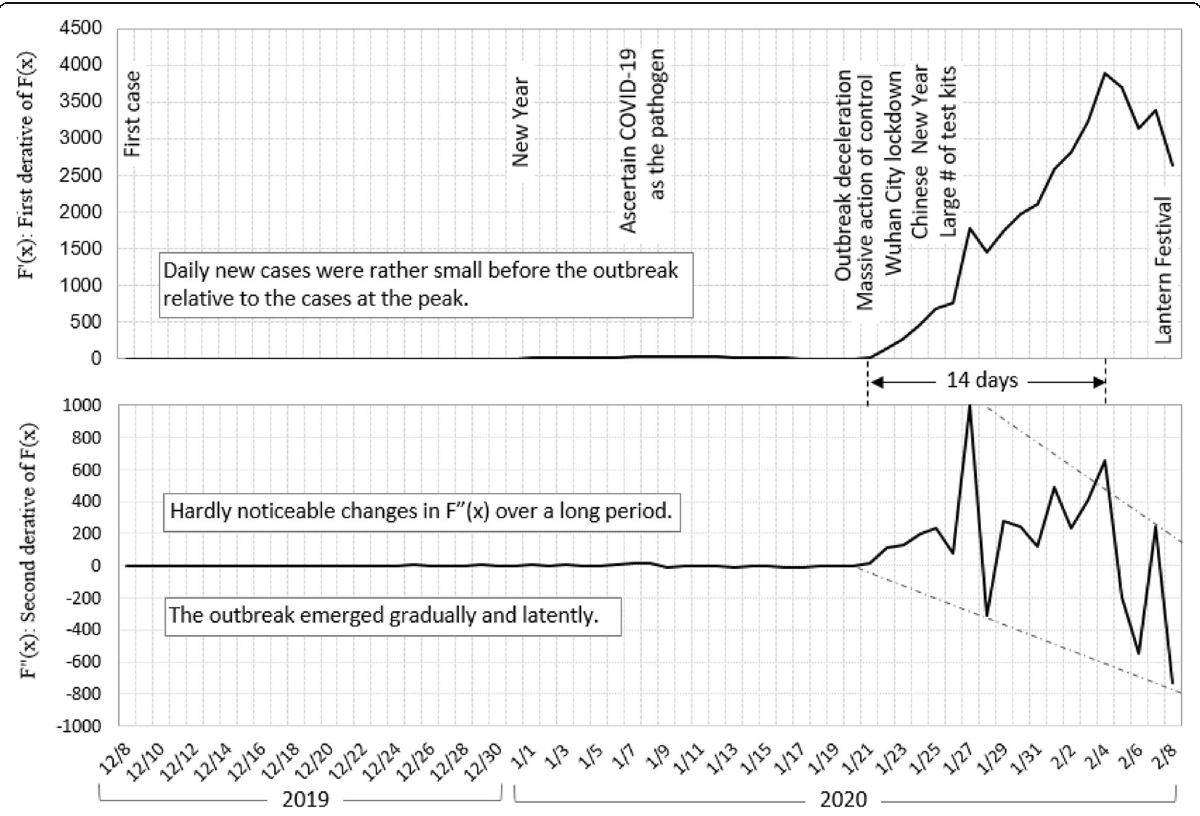
Fig. 2 The first F ′ (x) and second derivative F ″ (x) of diagnosed COVID-19 (formally 2019-nCoV infection) F(x) before, during and after declaring the outbreak in first 2 months of the